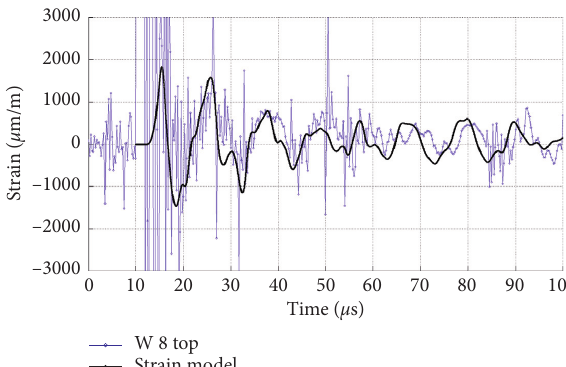
Figure 23: Results of the medium-intensity test on Inermet ® 180, acquired hoop strain (blue) without smoothing function and simulated signal (black).